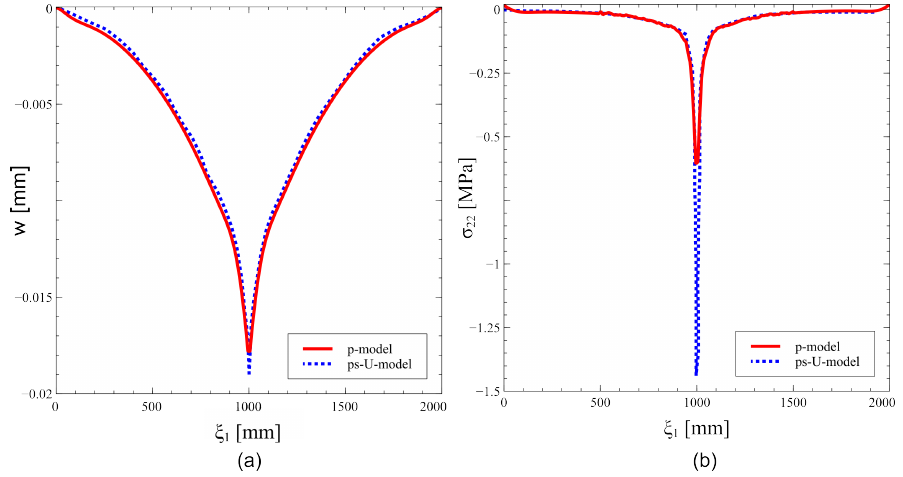
Figure 20. Variable stiffness cylindrical elliptical shell: comparison between p − and ps − U − models: ( a ) displacement and ( b ) normal stress